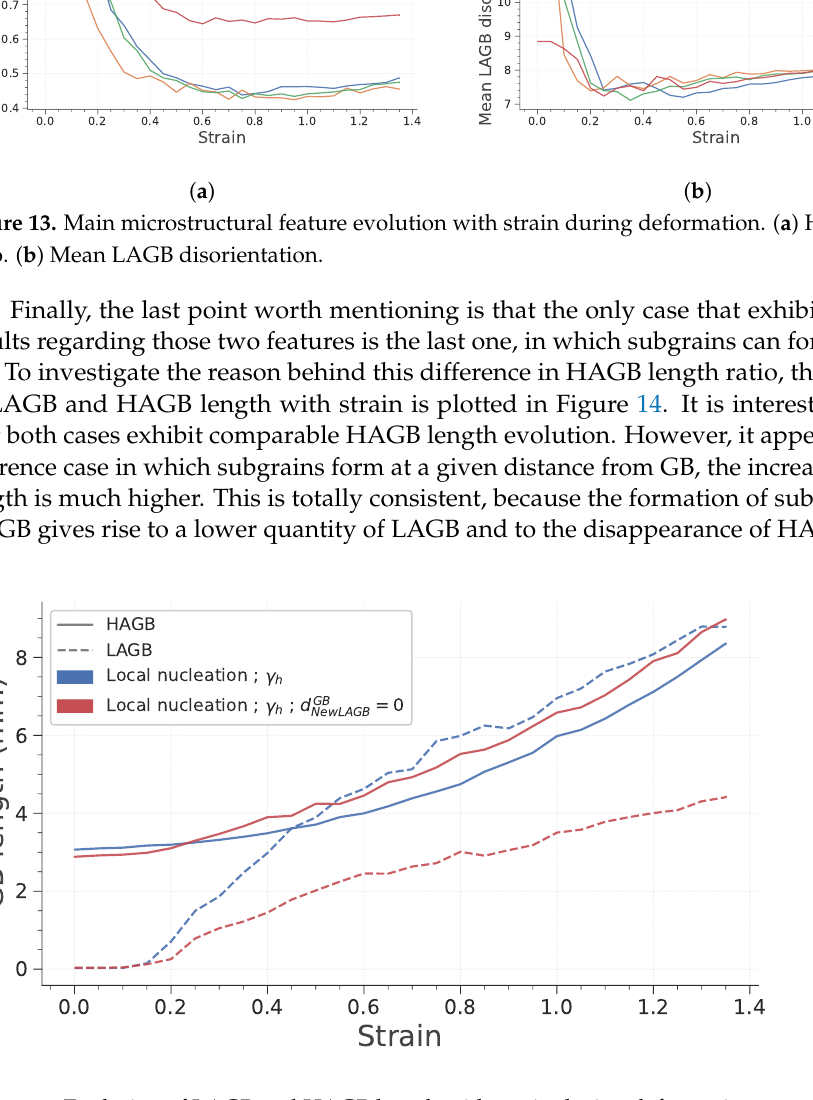
Figure 14. Evolution of LAGB and HAGB length with strain during